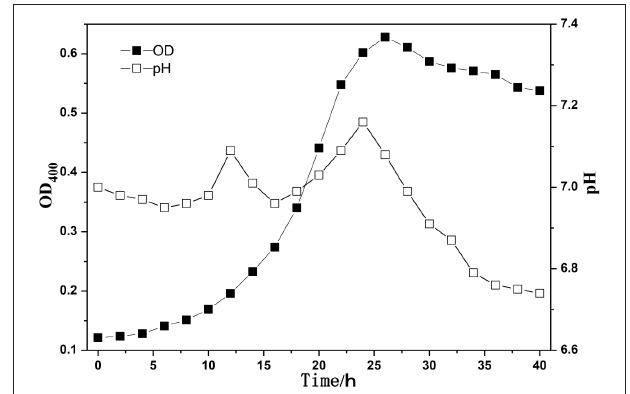
FIGURE 1 | The growth characteristics of the microorganism.